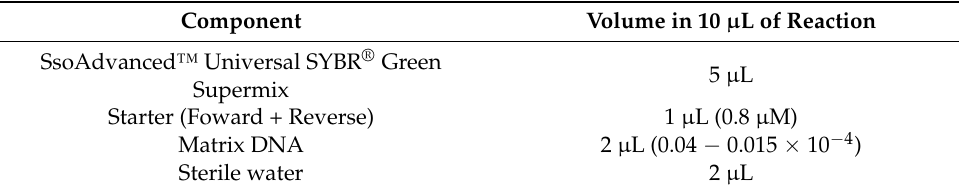
Table 3. PCR mix components.